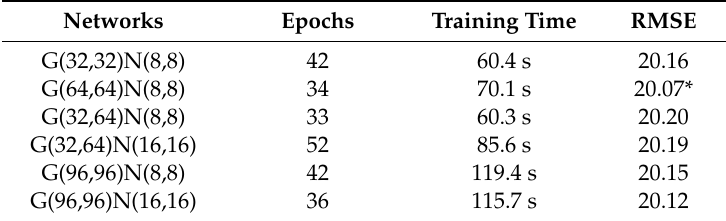
Table 4. Comparison of RMSE result (batch size = 128).